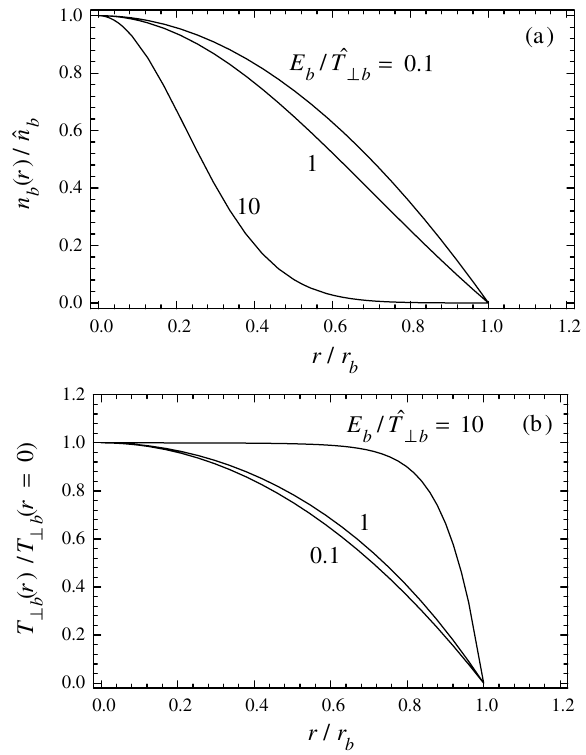
to 10 . The corresponding values of tune depression )=) [Eq. (19)] are also shown in Fig. 3. Note from 0 Fig. 3 that (cid:1) r (cid:3) increases monotonically from (cid:1) r (cid:4) 0 (cid:3) (cid:4) (cid:1) r (cid:3) = ^ nn FIG. 1. Plots of normalized (a) density n and (b) (cid:3) (cid:4) E at the beam edge. Moreover, com- 0 to (cid:1) r (cid:4) r b b b b (cid:1) r (cid:3) =T (cid:1) r (cid:4) 0 (cid:3) versus r=r obtained from temperature T ? ? b b b paring Figs. 3(a) and 3(b), (cid:1) r (cid:3) is nearly parabolic in the (cid:25) 1 , and E (cid:4) 0 : 1 ; 1 ; 10 = ^ TT Eqs. (20) and (21) for ^ ss ? b b b (cid:25) 1 [ ^ ss (cid:4) 0 : 1 in Fig. 3(a)], beam interior when ^ ss b b whereas (cid:1) r (cid:3) remains close to zero in the beam interior, and increases rapidly to ! 1 [ ^ ss (cid:4) 0 : 999 in Fig. 3(d)]. At high space- when ^ ss b b